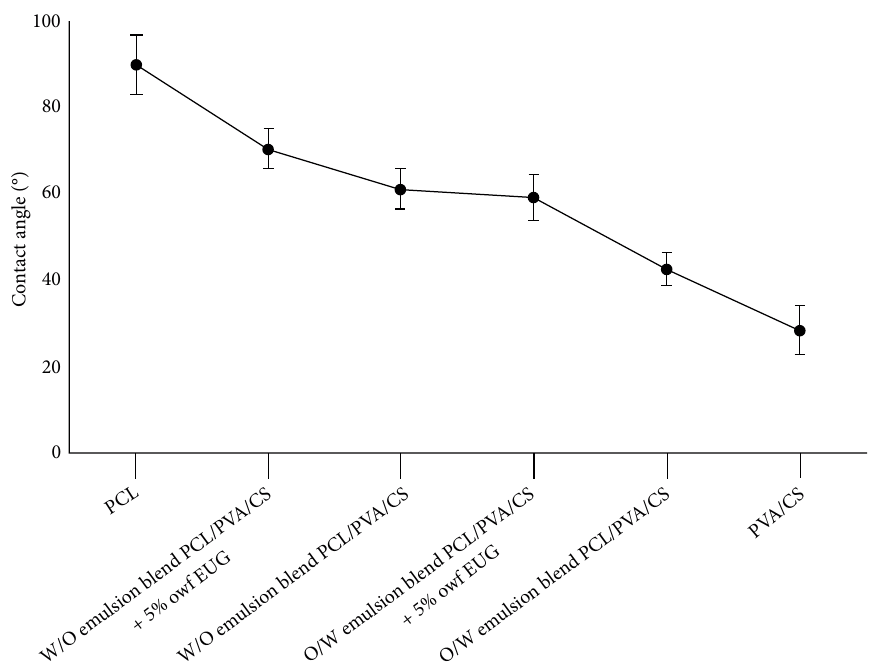
Figure 3: Variation of contact angle on pure PCL, PVA/CS and electrospun PCL/PVA/CS fiber mats prepared from W/O and O/W emulsions, with and without EUG.